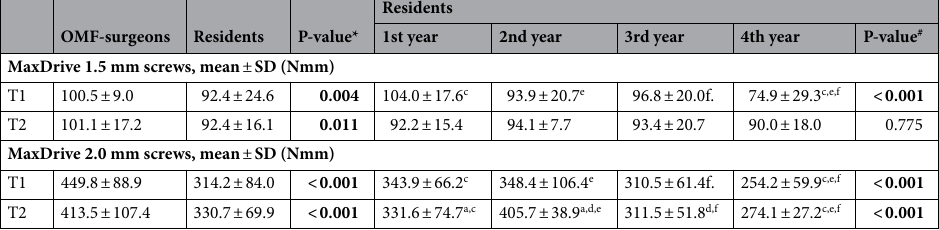
to the 1.5 mm osteosynthesis screws at T1 and T2, respectively (Table 2, Fig. 3a). The residents applied 92.4 ± 24.6 and 92.4 ± 16.1 Nmm torque to the 1.5 mm osteosynthesis screws at T1 and T2, respectively. The torque applied to the 1.5 mm screws by the residents at both test moments was significantly lower than that applied by the